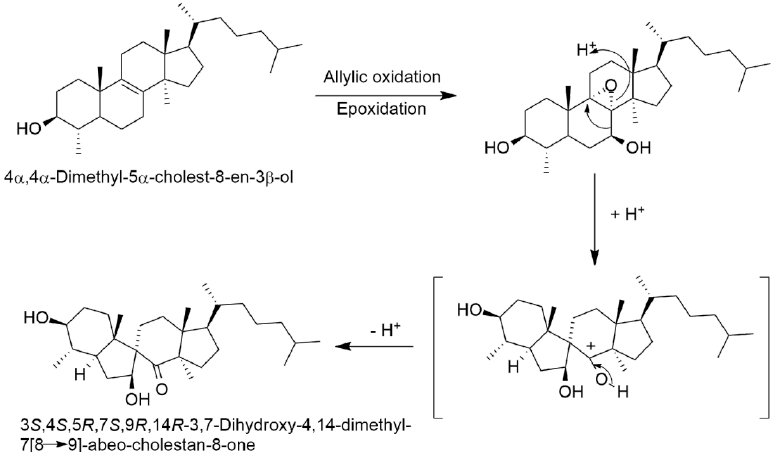
Figure 7. Hypothesis for the biosynthesis of the spirotriterpene (adapted from [2]). Sterols and triterpenes are synthesized via the mevalonate pathway as aforemen-